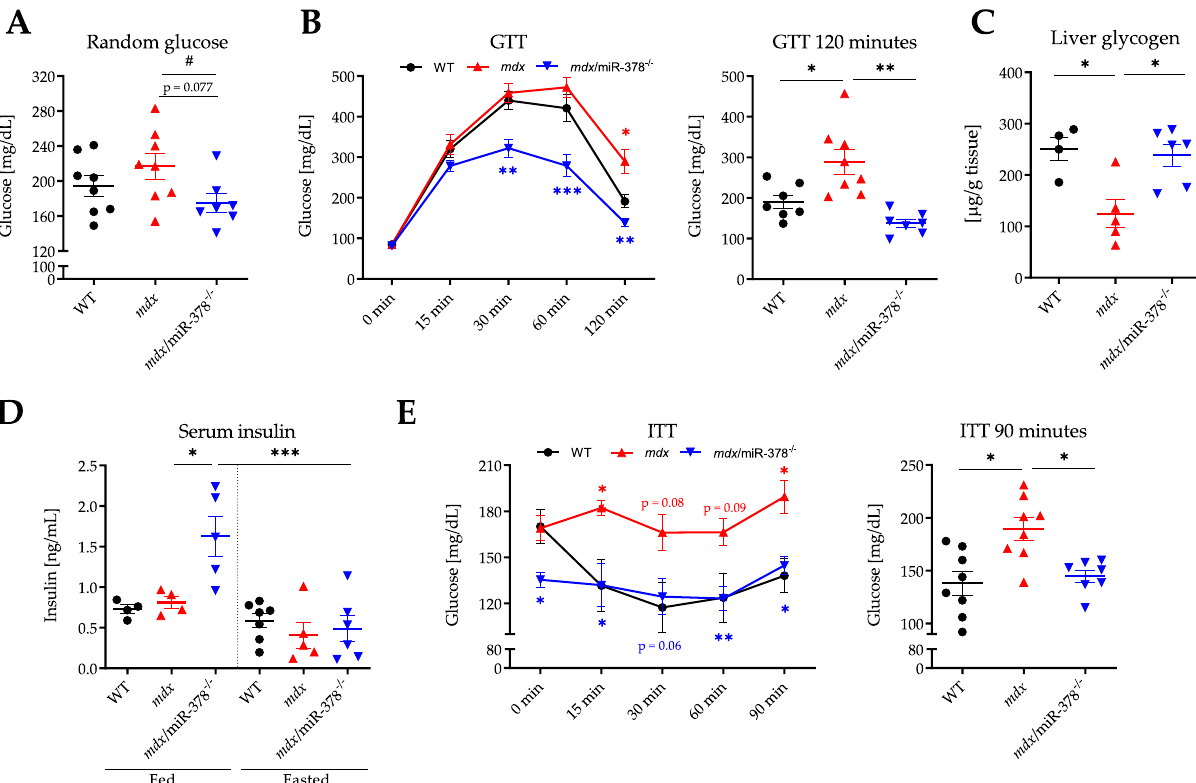
Figure 5. Disturbed systemic glucose homeostasis in the mdx mice is affected by the miR-378 loss. ( A ) The glucose level under non-fasting conditions was measured with a glucometer in the blood from the tail tip; n = 7–8/group. ( B ) A glucose tolerance test (GTT) was performed after overnight fasting. Glucose concentration was assessed in the blood from the tail tip before (0 min) and 15, 30, 60, and 120 min after i.p. injection of glucose solution; n = 7–8/group. ( C ) Liver glycogen content was evaluated after overnight fasting with the use of a biochemical assay; n = 4–6/group. ( D ) Serum insulin concentration was determined both under non-fasting conditions (fed) and after overnight fasting (fasted) by ELISA; n = 4–7/group. ( E ) Insulin tolerance test (ITT) was performed after 4 h of fasting. Glucose concentration was measured in the blood from the tail tip before (0 min) and 15, 30, 60, 90 min after intraperitoneal injection of insulin; n = 7–8/group. Data are presented as mean ± SEM. * p < 0.05; ** p < 0.01; *** p < 0.001 by ( A, C, D ) one-way ANOVA with Tukey’s post-hoc test or ( B, E ) by two-way ANOVA for repeated measures with Tukey’s post-hoc test. ( A ) # p < 0.05 additionally tested by Student’s t-test for comparison of mdx /miR-378 −/− vs. mdx